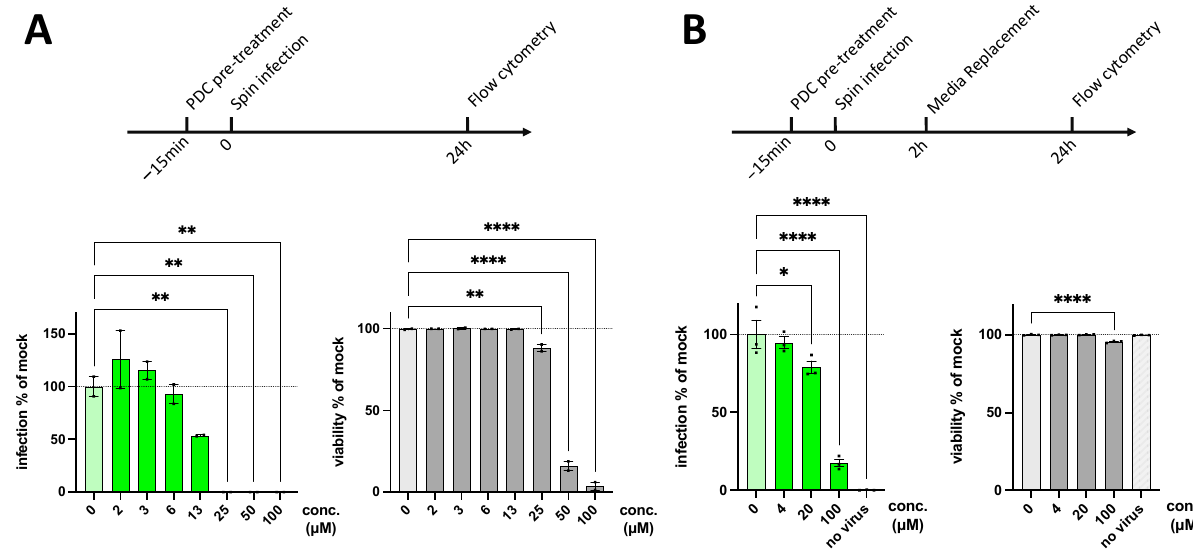
Figure 1. Anti-SARS-CoV-2 activity of PDC-109. ( A ) Calu6 ACE2 cells were pre-treated with different concentrations PDC-109 for 15 min and spin-infected with CoV-2 spike pseudoviruses (VSV*SARS CoV-2). Then, cells were incubated with virus and PDC-109 for 24 h and subjected to flow cytometry. ( B ) Calu6 ACE2 cells were pre-treated with different concentrations of PDC for 15 min and spin- infected with CoV-2 spike pseudoviruses in presence of PDC. Subsequently, excess virus and PDC were removed after 2 h of incubation, and cells were cultured for another 24 h. In both experiments, reporter virus signal and cell viability were assessed by flow cytometry. Frequencies of GFP+ cells are shown as a measure of VSV*SARS CoV-2 infection and were normalized to mock-treated samples (0 µ M). Significance was assessed by parametric one-way analysis of variance (ANOVA) tests, comparing all samples with the mock control and displayed as follows: **** p < 0.0001; *** p < 0.001; ** p = 0.001–0.01; * p = 0.01–0.05. IC50 and CC50 values, as well as the selective index, can be found in SI Table